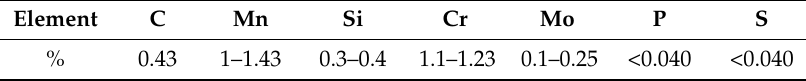
Table 1. Chemical composition (wt.%) of CrMo low alloyed